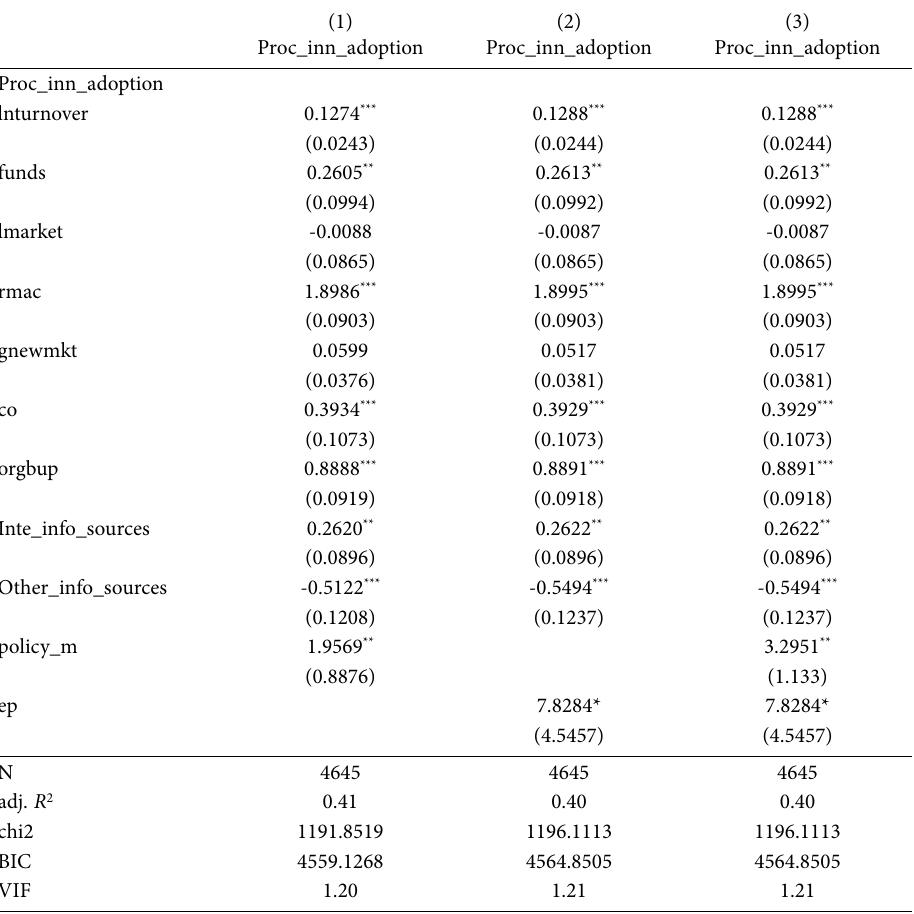
Table 3. Logit regression result from panel